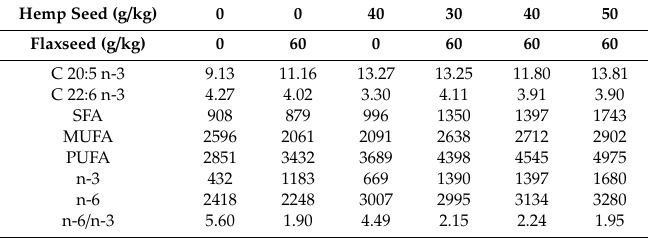
Table 3. Concentrations of fatty acids in the broiler diets (mg / 100 g).